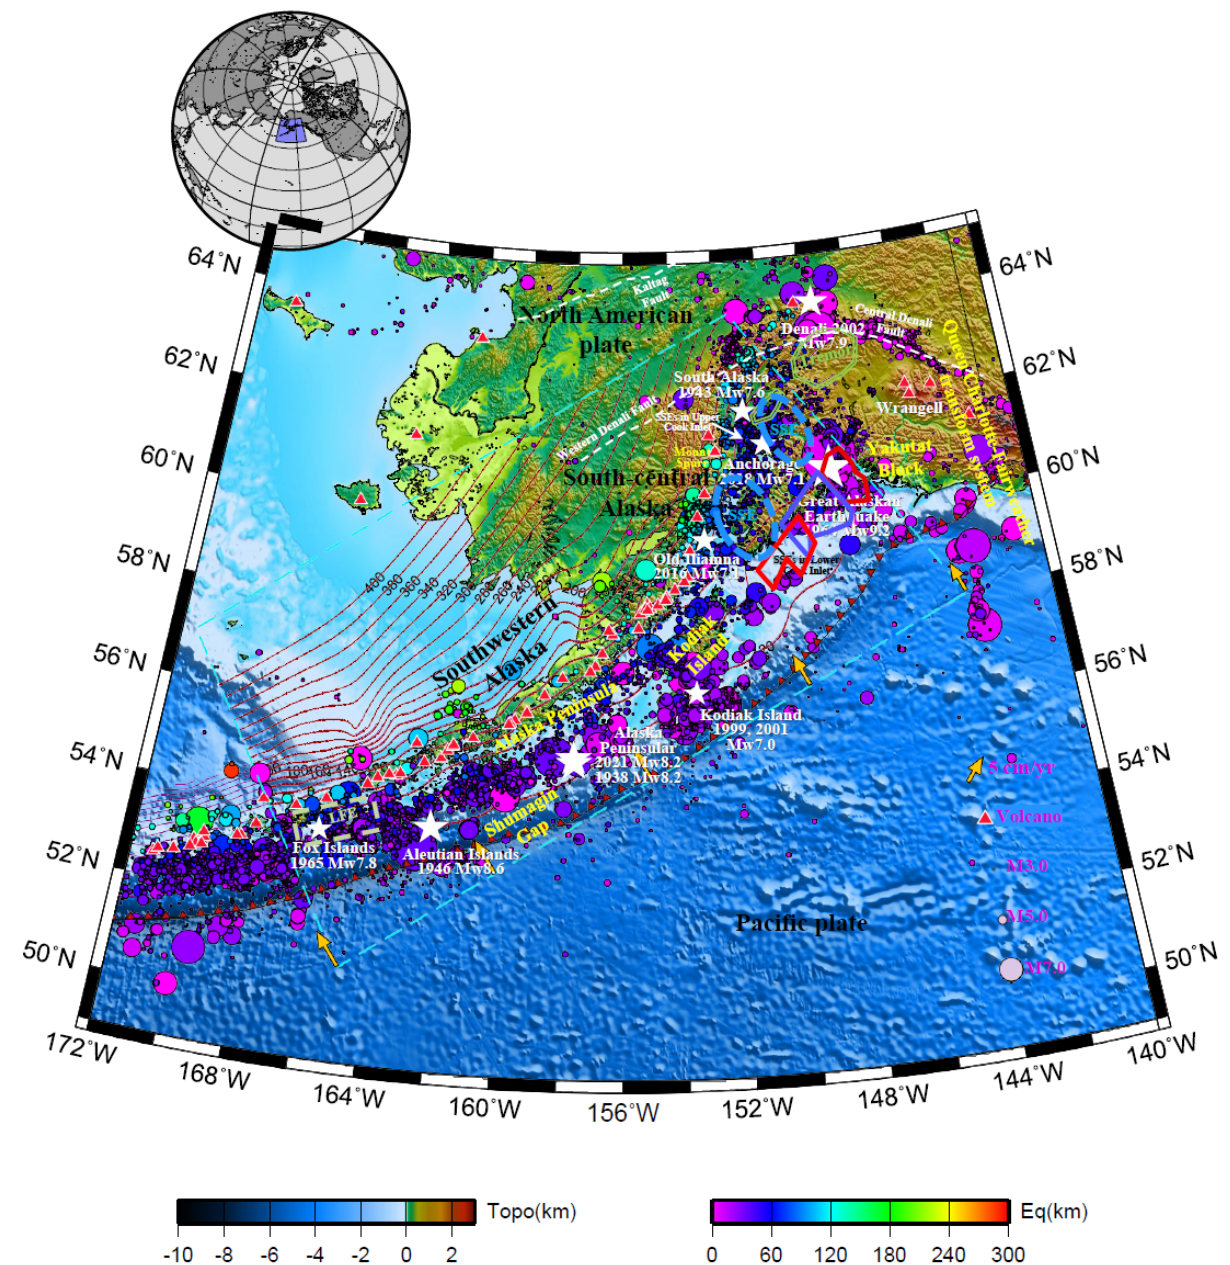
Figure 1. Tectonic map. The color indicates surface topography (ETOPO, [14]). The light blue dotted line marks the model area. The yellow arrows denote the direction (orientation) and velocity (length) of subduction, and the red barbed lines mark convergent plate boundaries (with the teeth on the overriding plate). The red curves represent the isodepth contours of the subducted Pacific plate with a contour interval of 20 km (Slab 2.0, [15]). Red triangles indicate arc volcanoes [16]. The colored spheres all indicate M > 3 earthquakes (IRIS) from 1 January 2000 to December 2010 and all M > 5.5 earthquakes from 1 January 1900 to December 2000 (Centennial Database). Earthquake magnitudes are indicated by sphere color. The blue ellipses with dashed lines represent the slow slip event patches in the Upper Cook (2008 − 2012, [17]) and Lower Cook Inlets (2010 − 2011, [18]). Green areas show the distribution of deep tremors [19]. The green dashed line indicates low-frequency earthquakes [20]. Bold blue bold lines indicate the 1992.0–2004.8 (~M 7.8) Slow Slip Event, and bold red lines indicate the 2009.85–2011.81 (~M 7.2) Slow Slip Event [21,22]. The white dashed lines indicate the Kaltag Fault and Western-Central Denali Fault